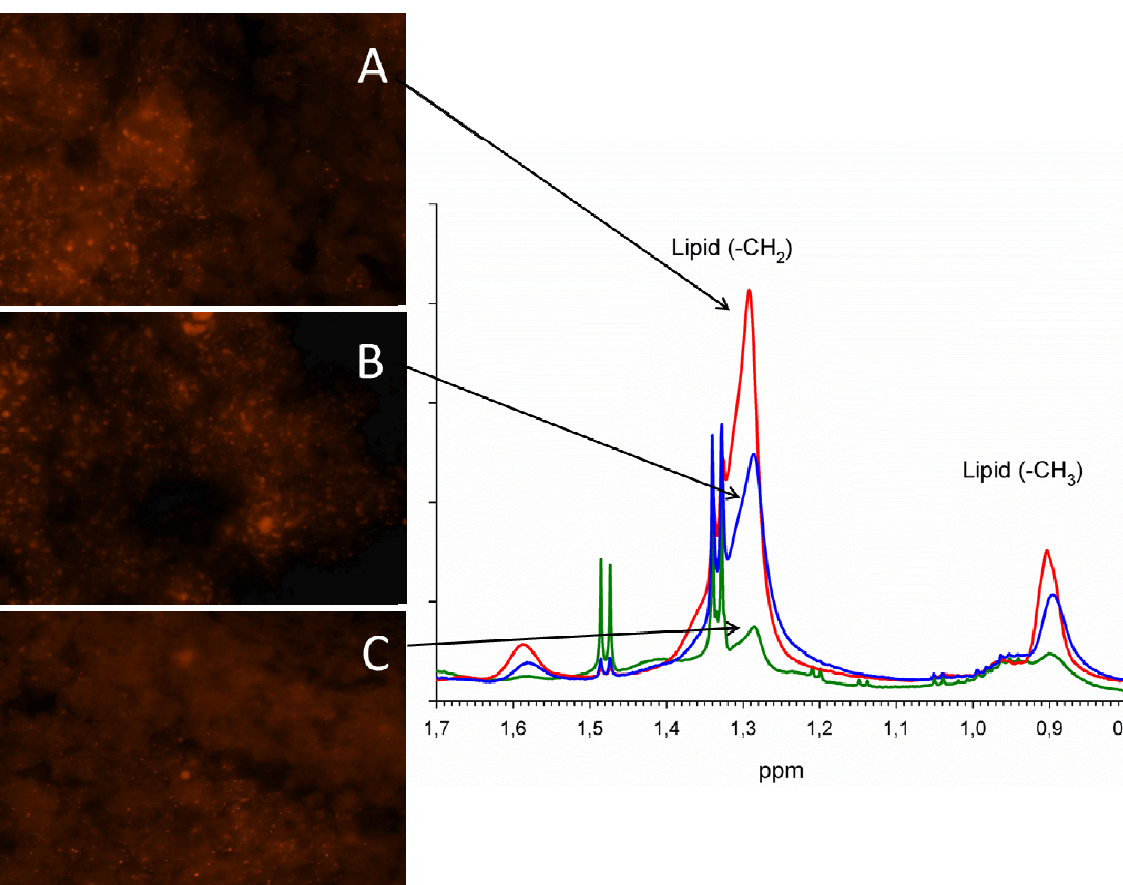
Figure 3. Nile Red fluorescent-stained images showing lipid droplets in three brain metastases originating from lung carcinoma (A, B, C) and their corresponding mean normalized single-pulse spectra (1.6–0.8 ppm), which demonstrate signal differences due to methylene (1.3 ppm) and methyl groups (0.9 ppm) in the mobile fatty acyl